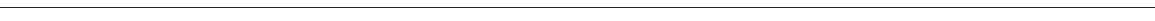
FIGURE 2 | the novel prosomeric notion of “acroterminal area.” (C) Modified drawing showing the alternative columnar model of Herrick (1910), as defined in an adult urodele. This initial study of Herrick still admitted the sulcus limitans of His (SL, compare with A,B ), but no longer depicted it as closely following in curvature the cephalic flexure; it was implied not to represent an axial landmark, and was wholly disregarded in subsequent work. The axial landmark role was assigned to the sulcus diencephali medius (SDM) and sulcus diencephali ventralis (SDV) (otherwise also known as “thalamic” sulci), arbitrarily held to separate “longitudinal columns’ identified as hypothalamus, pars ventralis thalami (p.vent.thal.) and pars dorsalis thalami (p.dors.thal.). An additional sulcus nearly orthogonal to the SDM, which separates the habenular region or epithalamus (hab.) from the p.dors.thal, was taken as sulcus diencephali dorsalis (SDD). Note the SDD finishes roughly under the posterior commissure (com.post.), thus implying that the pretectum (not identified) was half epithalamic and half dorsal thalamic. Remarkably, both SDM and SDV are clearly orthogonally disposed relative to the sulcus limitans, as well as to the forebrain roof and floor plates (check also A,B ), and they are not continuous either with the midbrain or with the telencephalon. Their topology with regard to the cephalic flexure is vaguely represented.